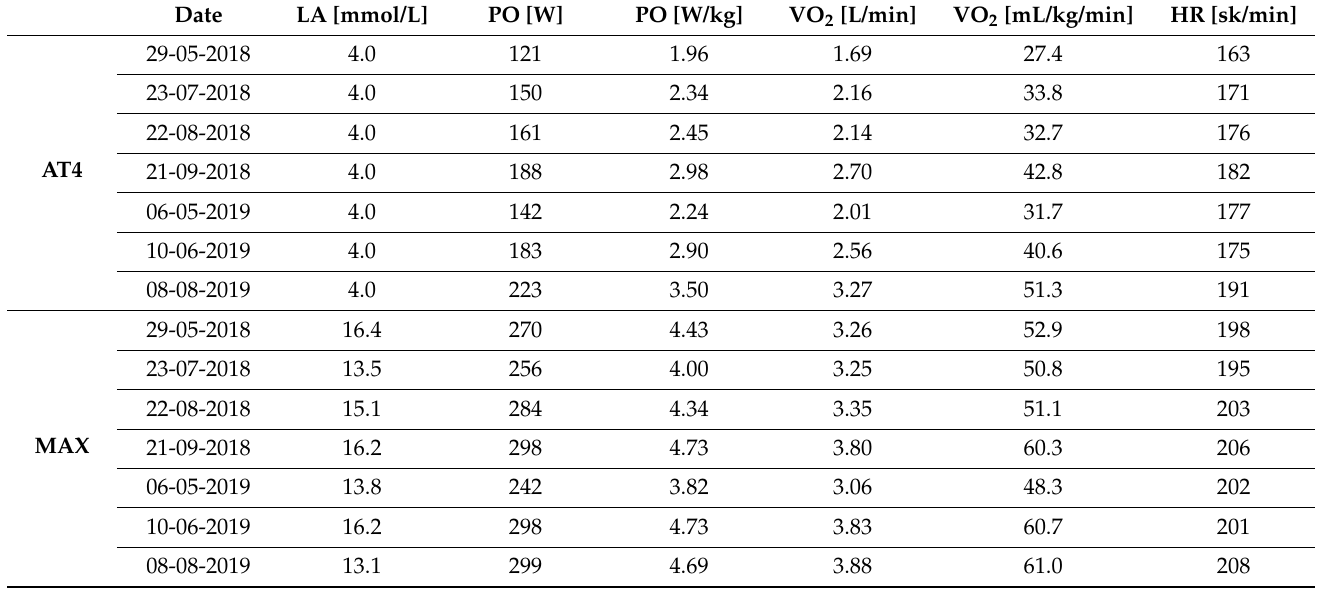
Table 5. Results of the graded exercise test on a cycle ergometer recorded for a short-track skater in